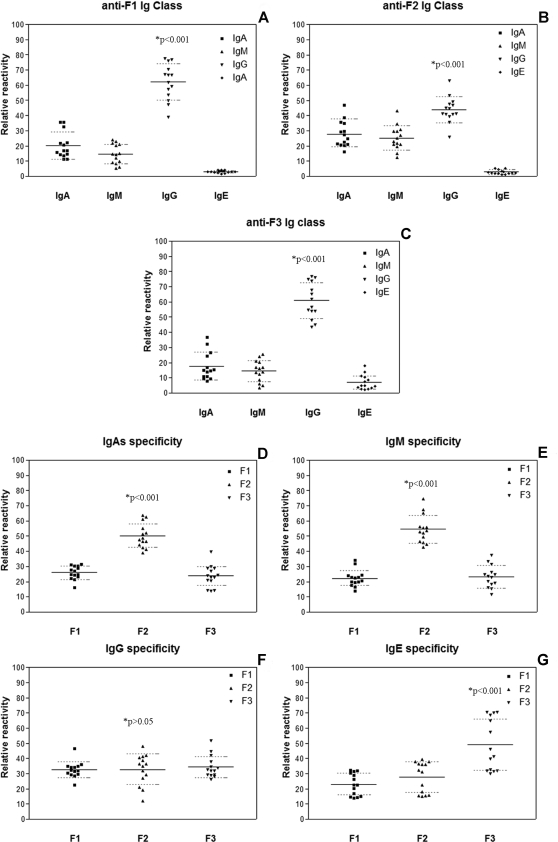
Pattern of immunoreactivity of the M antigen fragments and determination of antibodies specificity in sera of patients with histoplasmosis.Figure shows the distribution of patients' sera tested for each immunoglobulin class/fragment. Each symbol represents a single individual's serum. Dashed lines (……) represent the error bars and indicate a 95% confidence level; P values were determined using the One-way ANOVA test.